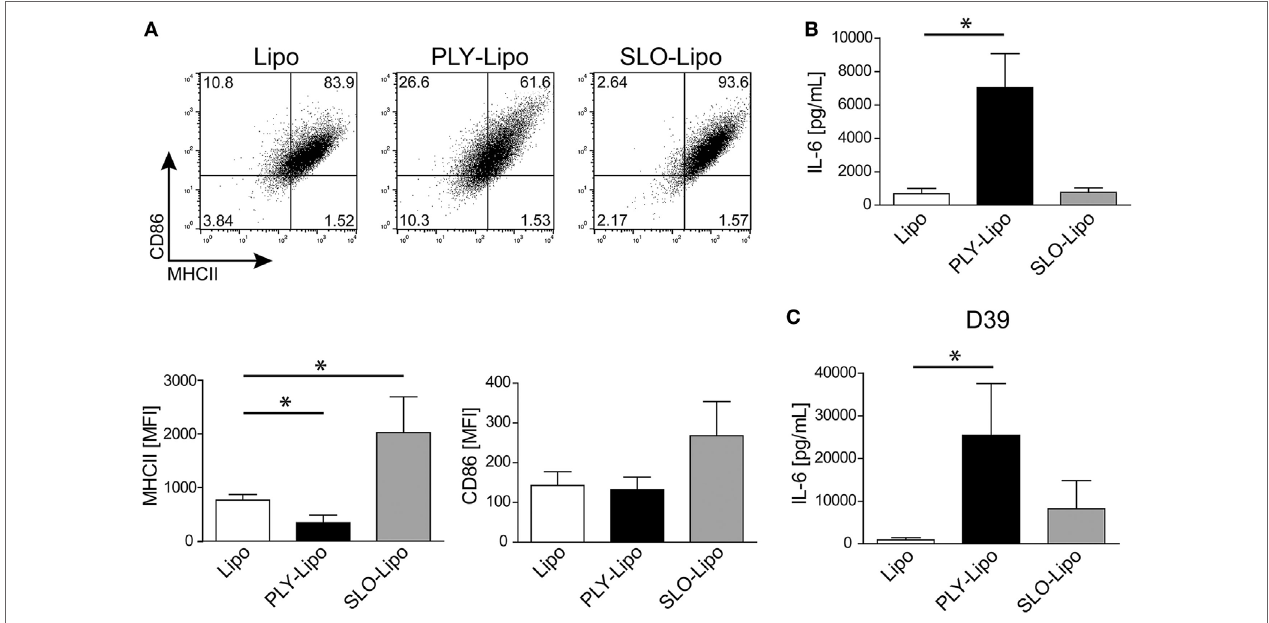
FigUre 5 | Streptolysin O (SLO)-bearing liposomes-induced macrophages display a phenotype distinct from Pneumolysin (PLY)-liposome induced macrophages. Day 7 M-CSF induced human macrophages were stimulated with PLY-liposomes (PLY-Lipo) or SLO-Liposomes (SLO-Lipo) for 48 h. Equal amounts (4 µg/ml) of PLY or SLO protein were incubated with 40 µg/ml liposomes for 10 min at room-temperature before addition to the cells. (a) SLO-liposomes induce an upregulation of MHCII and CD86 in macrophages. Macrophages were stimulated with PLY-Lipo, SLO-Lipo, or liposomes without pore-forming toxin (Lipo) and analyzed by FACS gated for CD14 + cells after 48 h. Expression levels of MHCII and CD86 were evaluated compared to control cells (liposomes only; Lipo). A representative FACS blot of one of three independent experiments is shown. Mean fluorescence intensity of MHCII and CD86 of CD14 + gated cells of three independent experiments are shown (mean ± SD, n = 6; * p < 0.05, unpaired t -test, two-tailed). (B) SLO-liposomes stimulation does not induce IL-6 production in macrophages. Human macrophages were stimulated as in (a) and IL-6 production was determined after 48 h from culture supernatants performing Bio-Plex assay (mean ± SD, n = 5; * p < 0.05, paired t -test, two-tailed). (c) Re-stimulation of SLO-Lipo induced macrophages with Streptococcus pneumonia supernatants. Human macrophages were stimulated with PLY-liposomes (PLY-Lipo) or SLO-liposomes (SLO-Lipo) for 48 h. After stimulation, cell media was removed, macrophages were washed once, and re-stimulated with supernatant from S. pneumonia strain D39 for 6 h. IL-6 production was analyzed by performing Bio-Plex measurements (mean ± SD, n = 4; * p < 0.05, paired t -test,